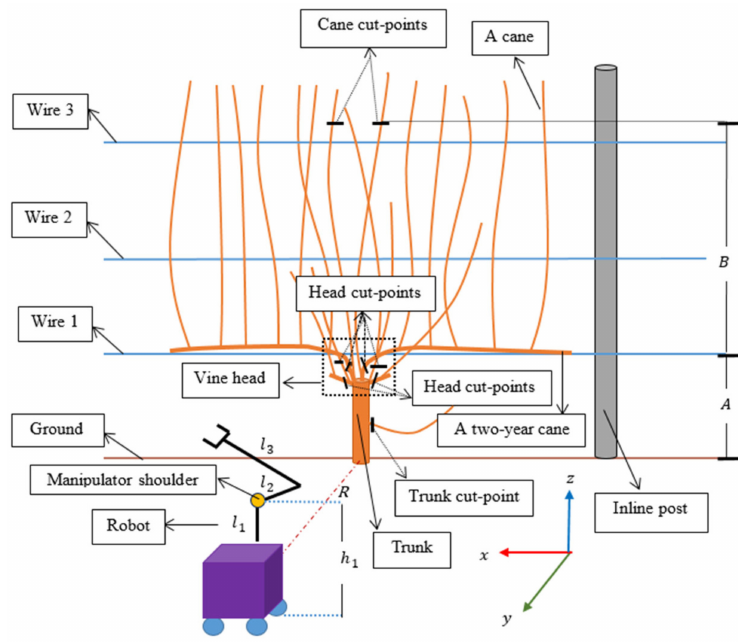
Figure 2. Robot winter cane pruning task space.